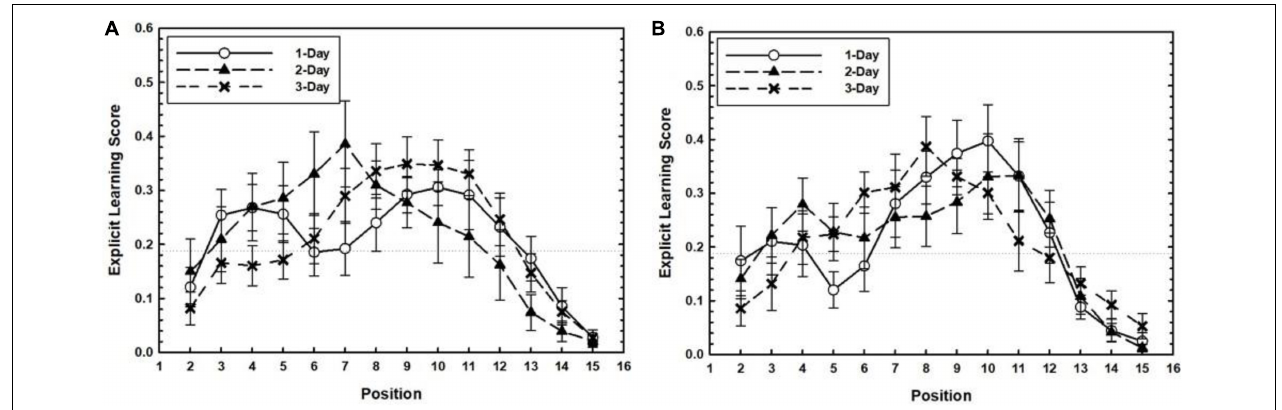
FIGURE 5 | For the 4–10 (A) and 7–13 conditions (B) , the transfer related Explicit Learning Score (ELS) is plotted as a function of Target Position separately for each Training Level. Error bars represent the